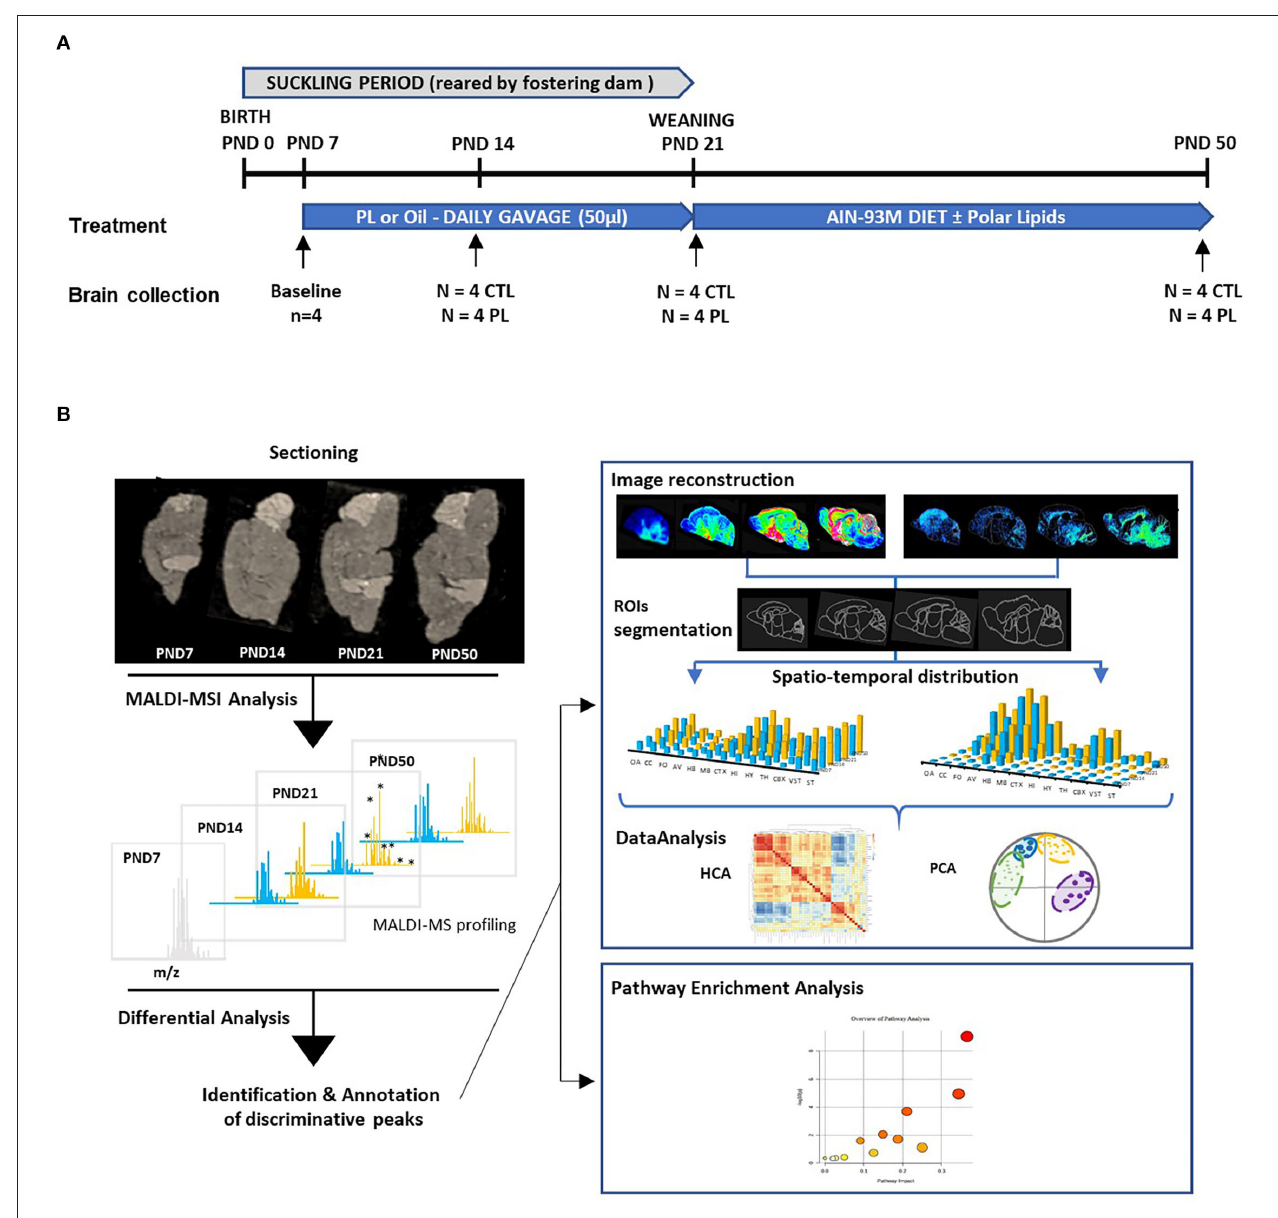
FIGURE 1 | Experimental design. (A) The experimental paradigm and the number of animals terminated at each time point are shown. At birth, 8 male rat pups were randomly allocated into 4 different litters reared by lactating dams. At PND 7, pups within each litter were randomly assigned to control (CTL) and polar lipids (PL) ( n = 4 per group). Nutritional supplementation started at PND 7 and lasted until the animals were terminated at respective time points. About 1Litter, consisting of 4 control and 4 PL animals, was terminated at PND 7, 14, 21 and 50, and the brains were collected. (B) A schematic overview of the MALDI-MSI analysis is described. In brief, 10- µ m-thick sagittal sections of brains from different time points were mounted on conductive MALDI slides. A full scan MALDI-MSI spectra was collected in positive and negative ionization mode. Discriminative peaks were identified by differential analysis between the two groups. Pathway enrichment analysis was performed using annotated molecular species. To obtain their spatiotemporal distribution, reconstituted molecular images were segmented in ROIs based on histological staining performed in juxtaposed section. Multivariate analysis was performed to identify pattern similarities among different annotated species.